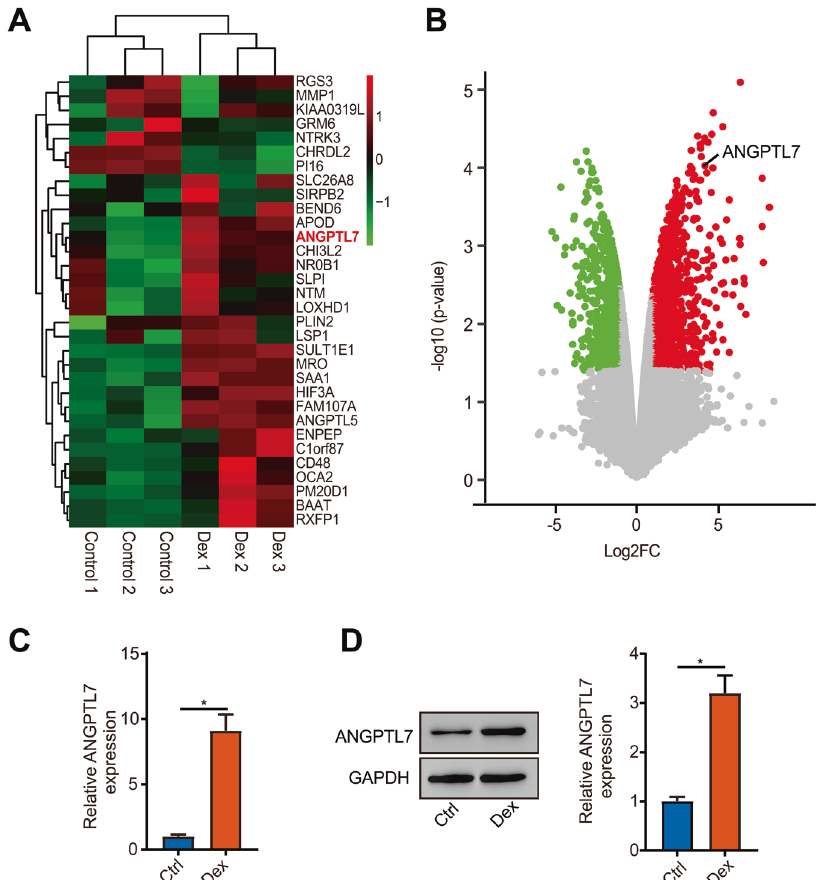
Fig. 1 Dexamethasone (DEX) induced ANGPTL7 expression in trabecular meshwork (TM) cells. A Heatmap of differentially expressed genes by analysis of TM cells treated with and without 100 nM DEX for 14 days from GSE65240. ANGPTL7 expression was distinctly upregulated with DEX treatment in TM cells. B Volcano plot of differentially expressed genes. ANGPTL7 is marked out. The red dots indicate distinctly upregulated genes. Fold change ≥ 2, P < 0.05. TM cells were treated with DEX or a solvent (ethanol) as a control for 14 days. C Messenger RNA and D protein expression of ANGPTL7 detected by qRT-PCR and western blotting showed high levels with DEX treatment. N = 3 from three biological replicates. * P <